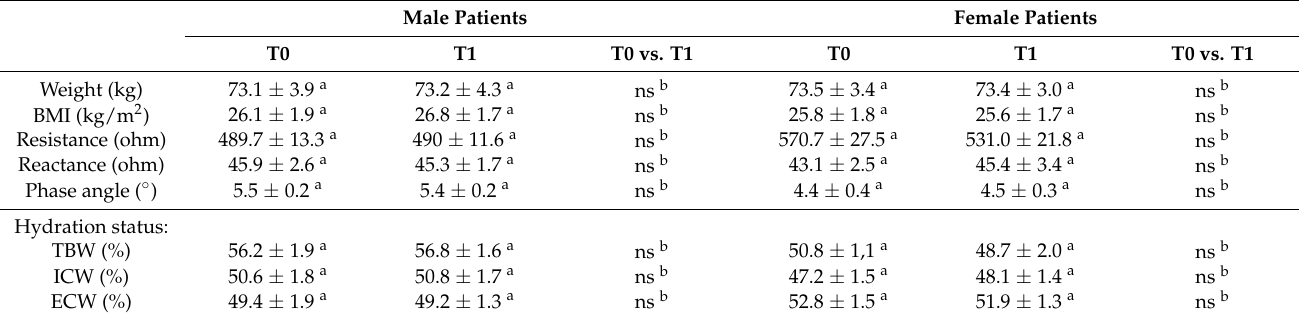
Table 6. Body composition assessment of control group divided into two subgroups according to gender.